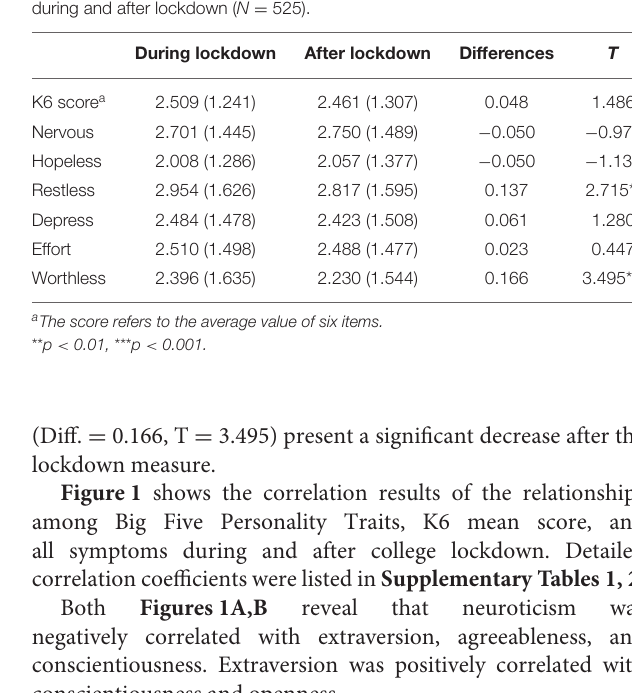
TABLE 2 | Descriptive statistics ( N = 525). TABLE 3 | Mean differences of K6 score and six symptoms’ scores between